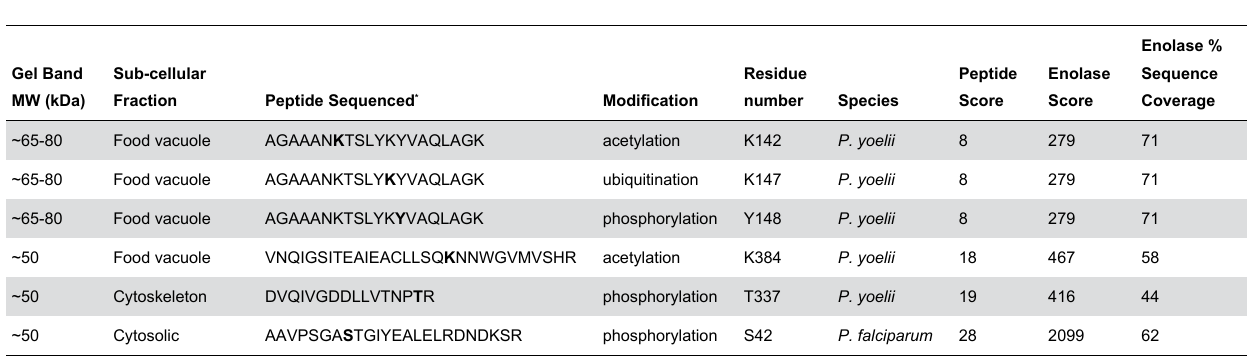
Table 1. Post-Translational modifications in Plasmodium spp Enolase.